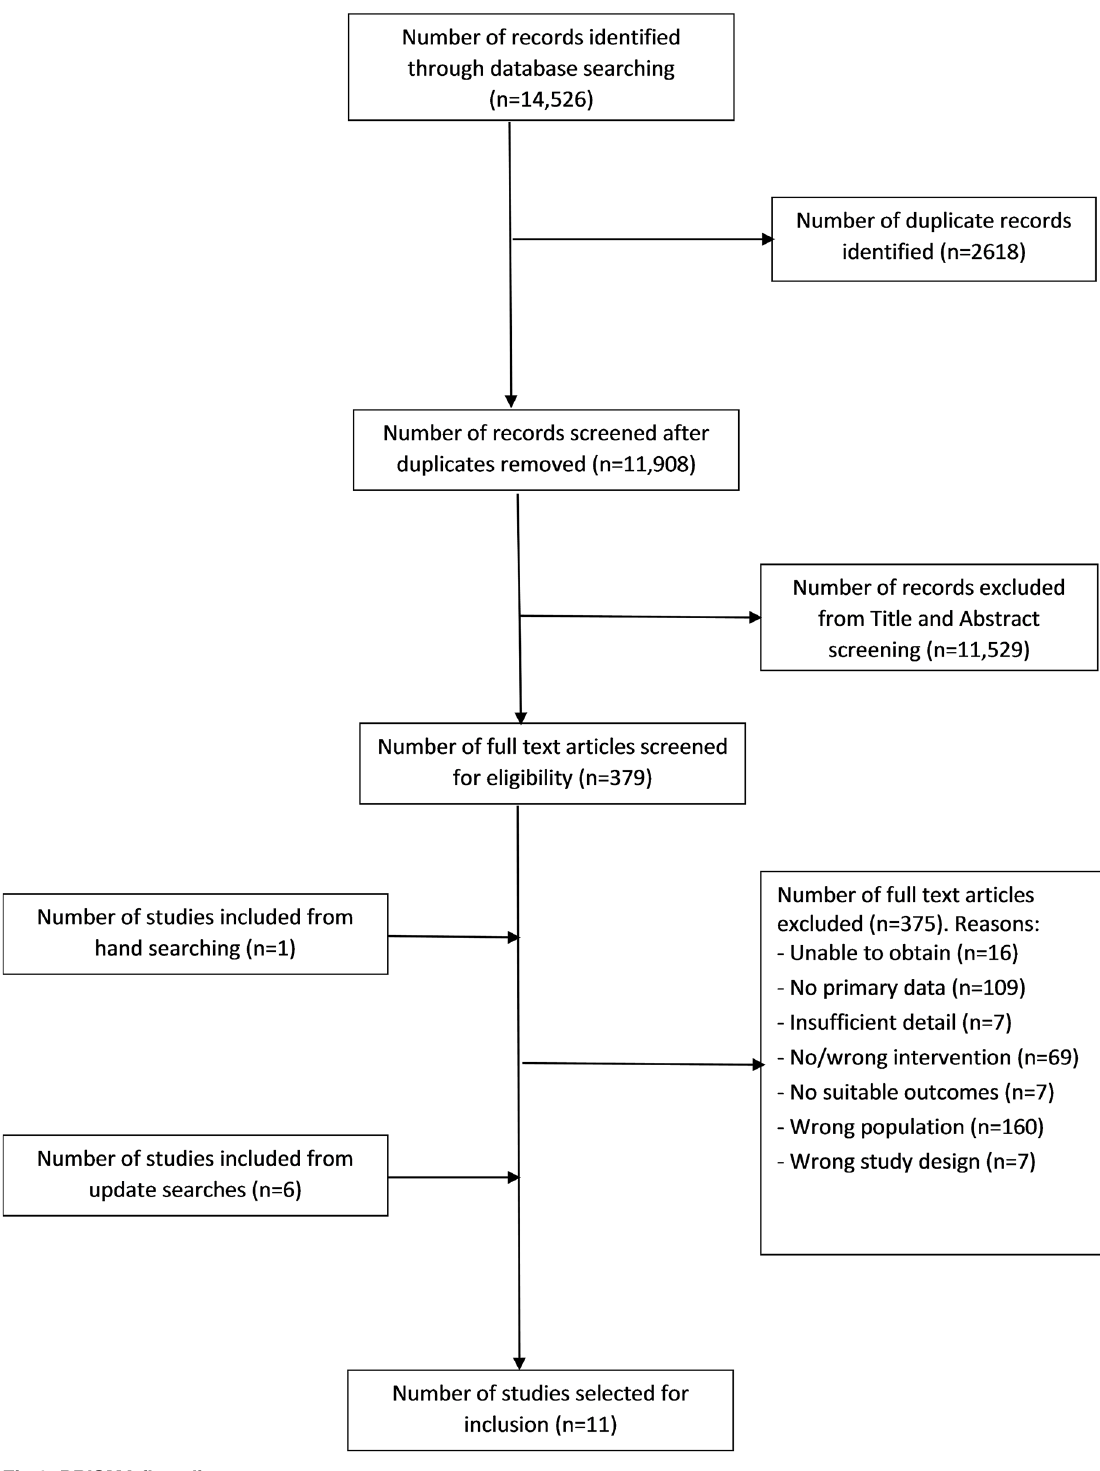
Fig 1. PRISMA flow